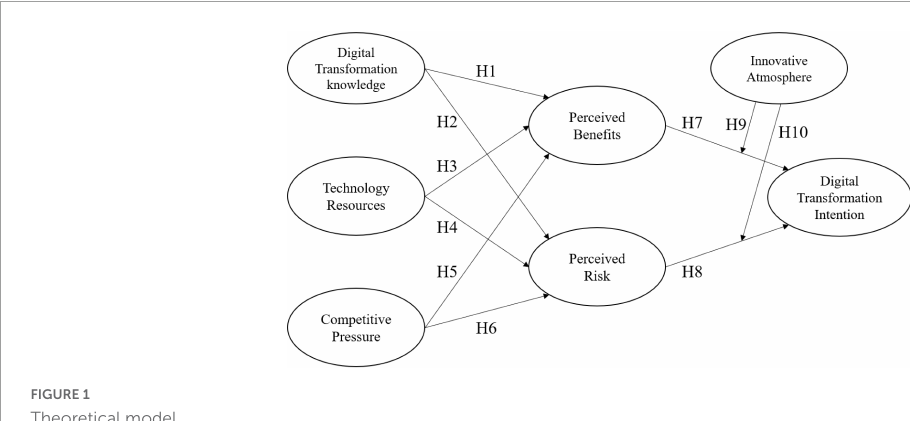
FIGURE1 Theoretical model.